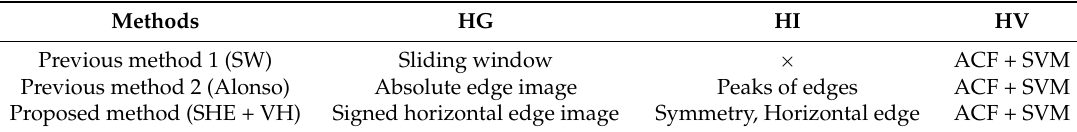
Table 1. The mean absolute errors with the proposed method and previous methods.